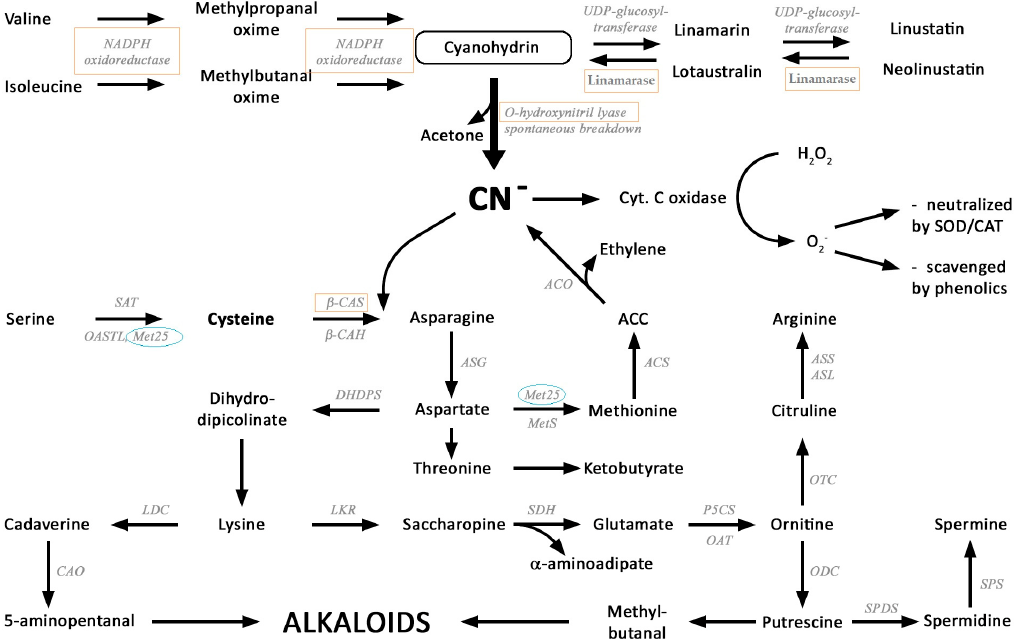
Figure 1. Metabolism of cyanogenic glucosides. Key enzymes marked on the scheme: biosynthesis: NADPH oxidoreductase (Val-monooxygenase), UDP-glucosyl-transferase; catabolism: linamarase ( β -D-glucosidase), O-hydroxynitryl lyase; CN − ions asymilation: β -CAS - β -cyanoalanine synthase, β -CAH- β -cyanoalanine hydratase, SAT-serine O-transacetylase, OASTL-O-acetylserine (thiol) lyase,